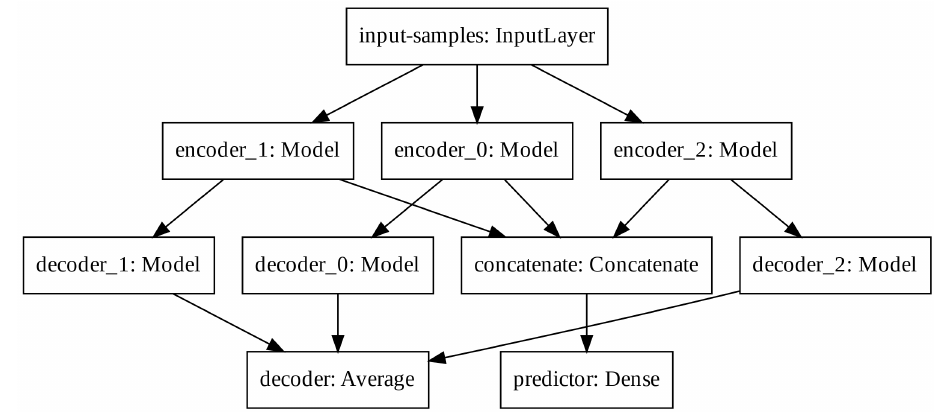
Figure 5. Modified Auto-Encoder